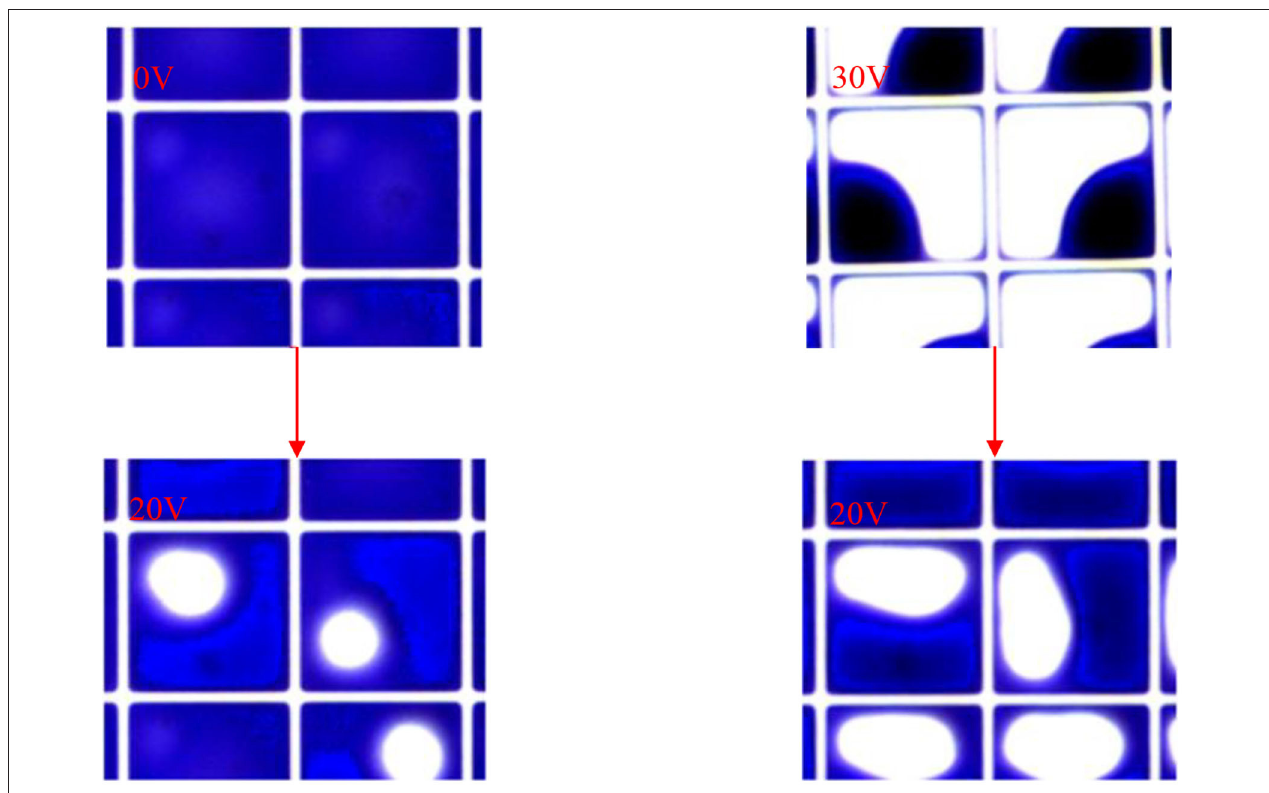
FIGURE 4 | Inconsistent performance of aperture ratio in a pixel. The driving voltage was increased from 0 to 20V and decreased from 30 to 20V, respectively, the aperture ratio was different at